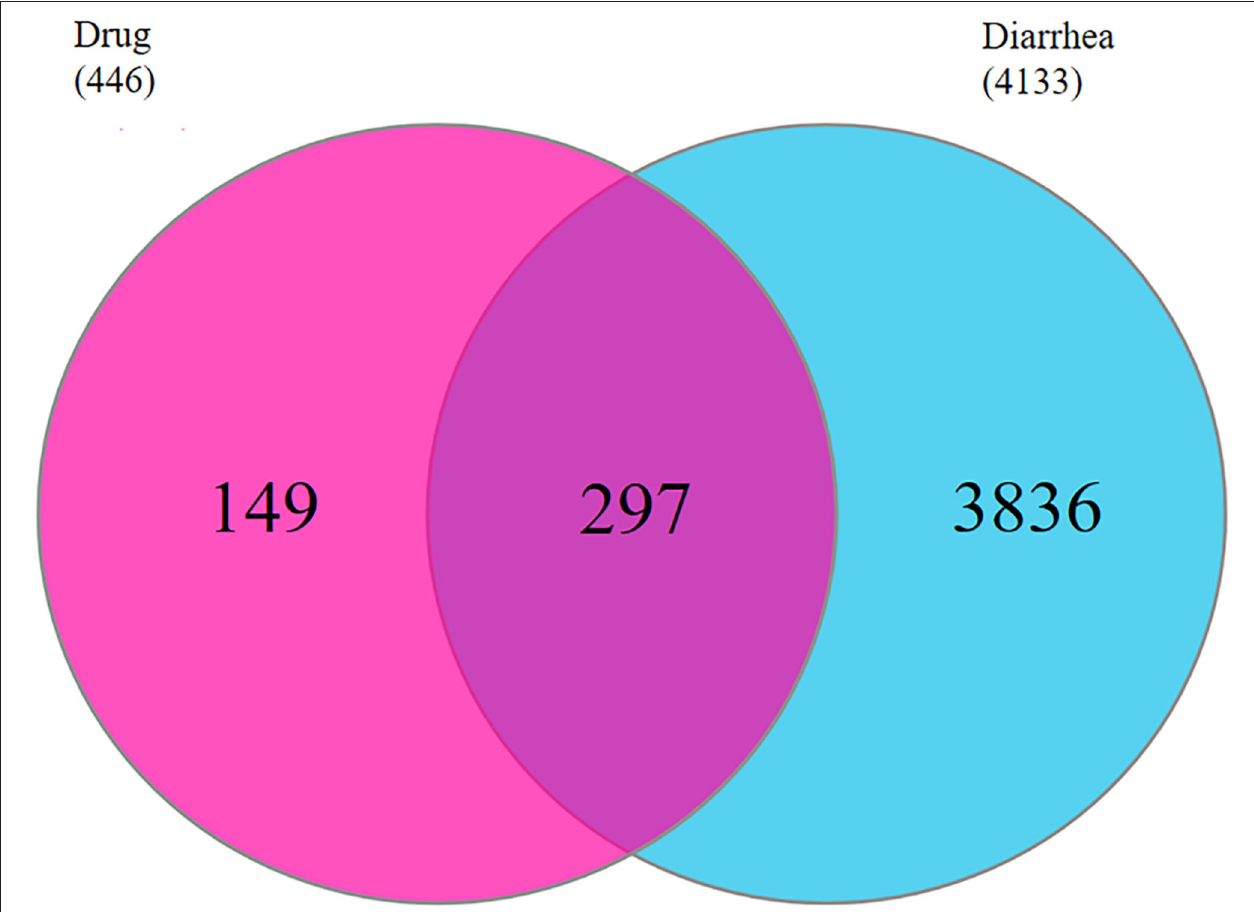
FIGURE 2 | The common targets of QJC and diarrhea were identified. The red circle represents 446 targets of QJC; the blue circle represents 441 targets of diarrhea; and the purple circle represents 297 common targets.